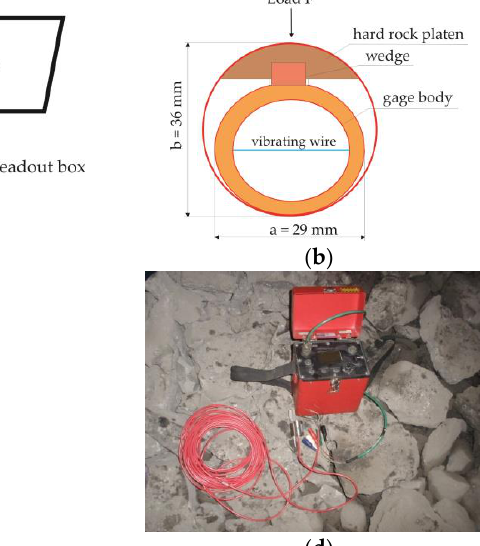
Figure 15 . Measurement of stress increase in the inter-room pillar: (a) Scheme of sensor location in the pillar; (b) A 4300EX sensor placed into the pillar; (c) Dimensions of the sensor; (d) GK-403 readout box.